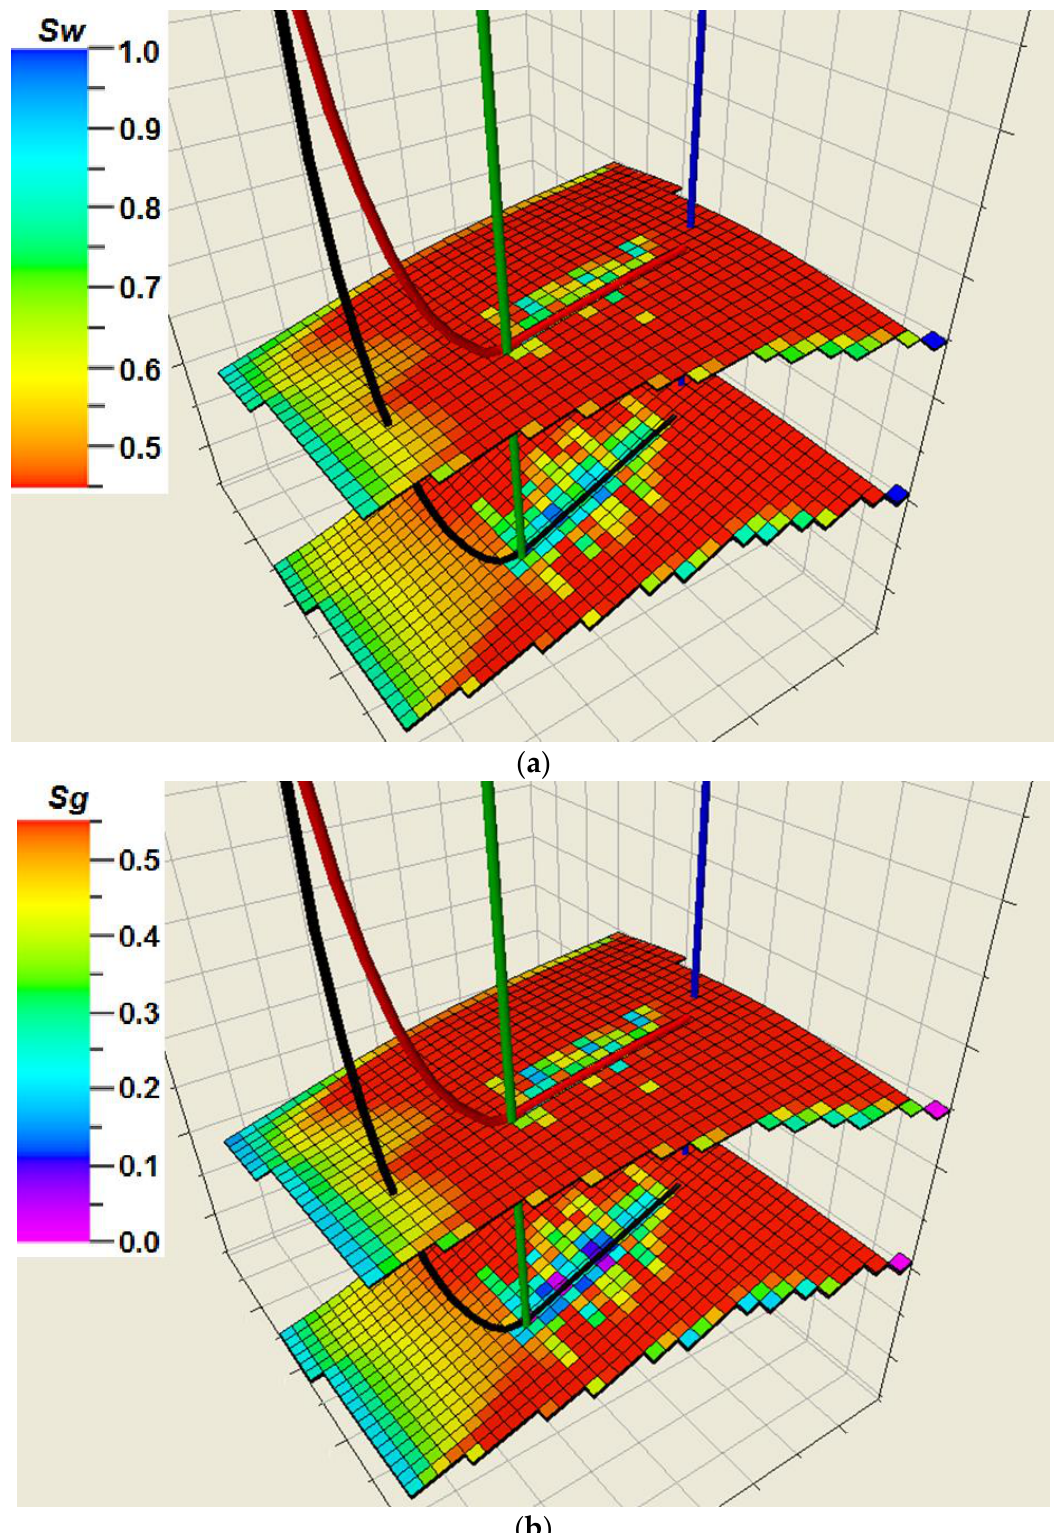
Figure 12. Changes in water saturation— Sw ( a ) and gaseous phase— Sg ( b ) in the fractures after 5 years from the end of CO 2 injection.